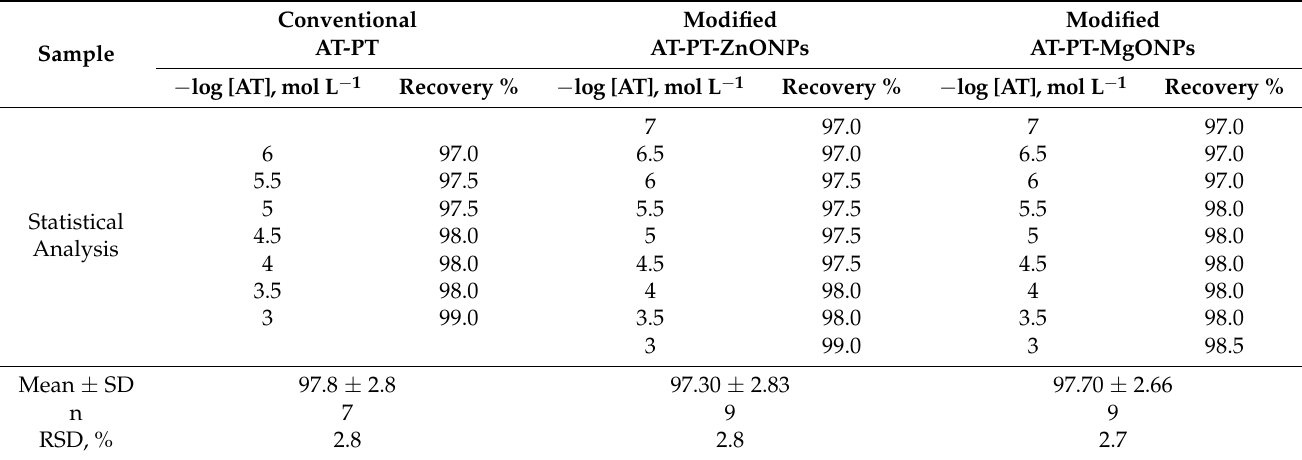
Table 3. The accuracy study for the AT estimation using the designed conventional coated wire AT-PT and modified AT-PT-ZnO and AT-PT-MgO nanocomposite